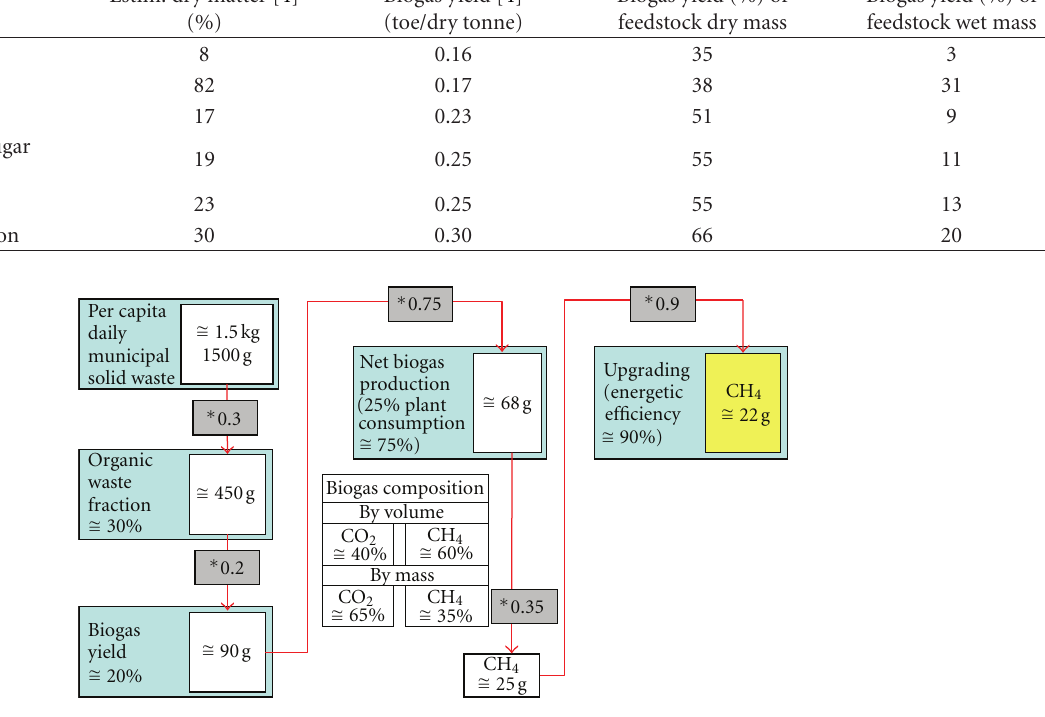
Figure 3: Per capita daily biomethane potential production from anaerobic fermentation of wet organic fraction of MSW.